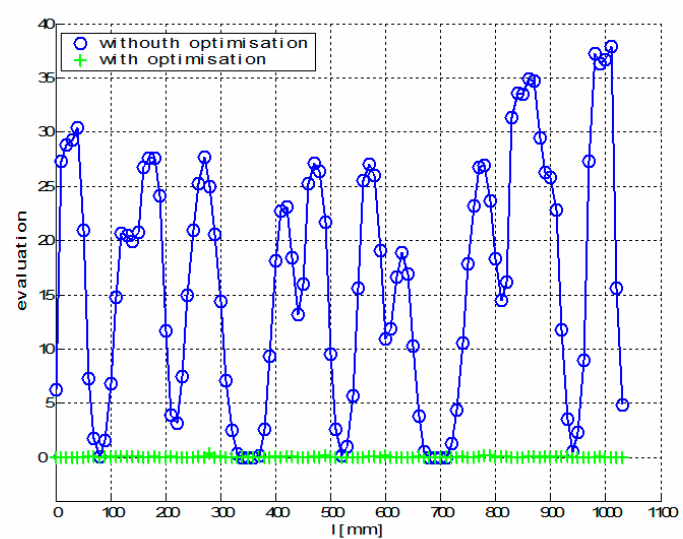
ϕ ( i ) ω ( i ) ) z ( i ) opt , opt , opt , opt , z H , 0, 0 ) for non-optimal REE trajectory during the BCS BCS zxF for BCSBCS HH